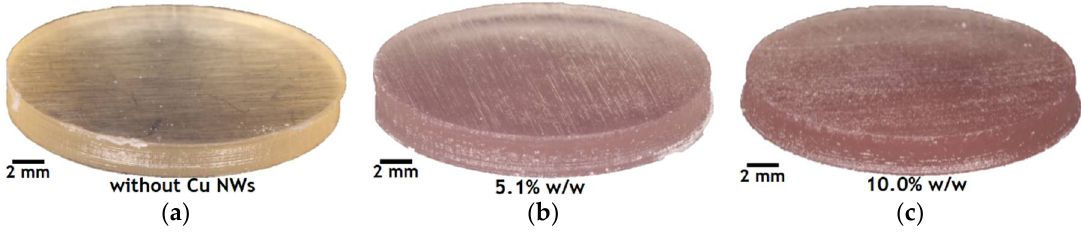
Figure 3. Manufactured circular substrates in the 3D Form 1+ printer. ( a ) without Cu NWs, ( b ) with Cu NWs at 5.1% w / w , and ( c ) 10.0% w / w